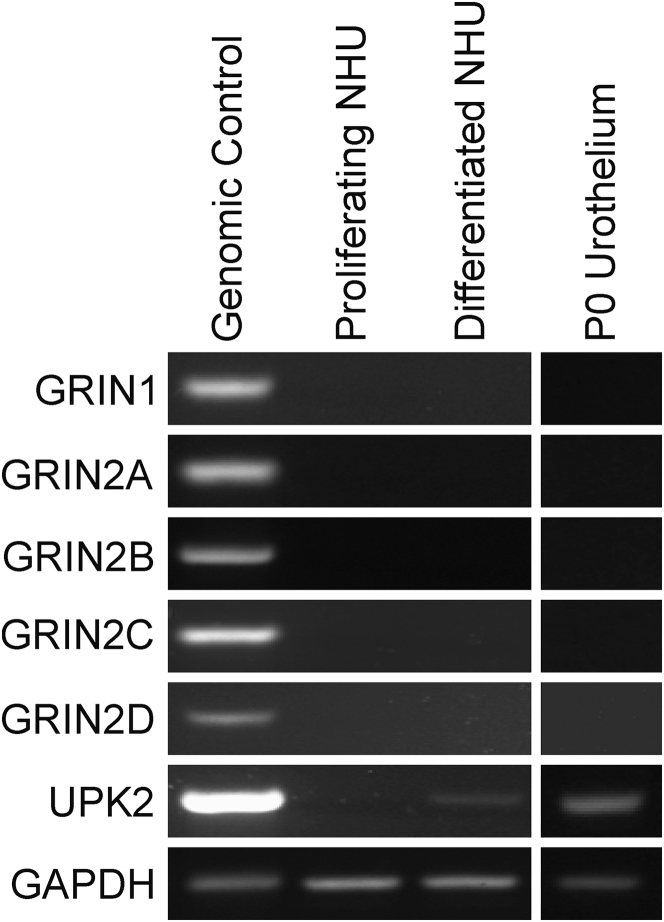
RT-PCR of NMDA receptor transcripts (GRIN isoforms). No expression of GRIN isoforms was detected in normal (nonimmortalized) human urothelial (NHU) cells under either proliferating or differentiated cell culture conditions. Furthermore, no GRIN expression was detected in freshly isolated urothelium after its separation from the underlying stroma. Representative images of one donor (proliferating and differentiated NHU) and one donor P0 urothelium are shown. Uroplakin 2 (UPK2) transcript expression was used to confirm urothelial differentiation, and glyceraldehyde-3-phosphate dehydrogenase (GAPDH) was included as an internal housekeeping control to confirm RNA integrity. In addition, no products were detected in reverse transcriptase–negative cDNA controls that were generated using each RNA preparation.